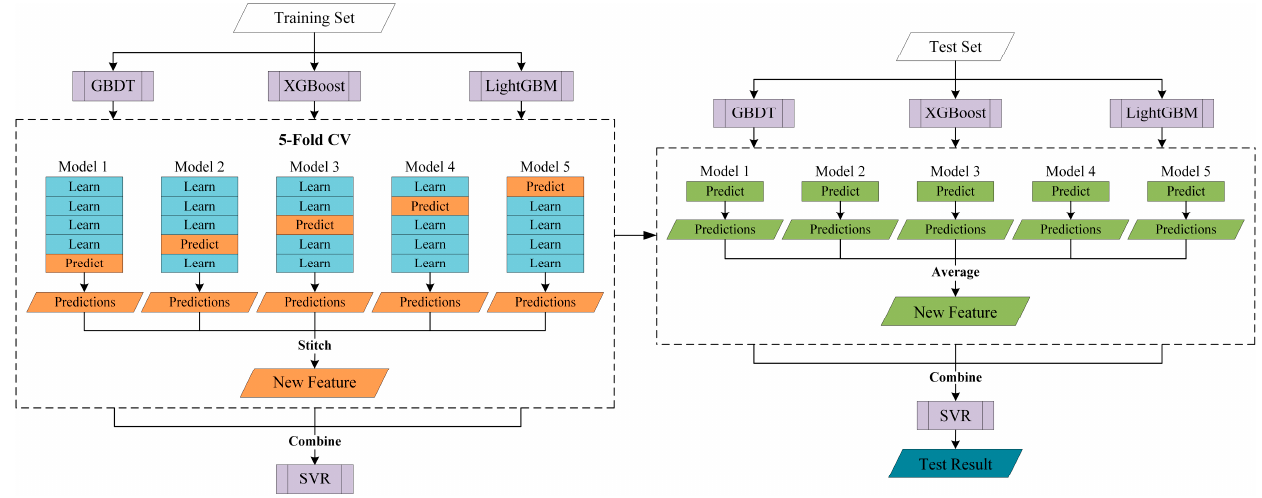
Figure 4. GXLS-Stacking model overall